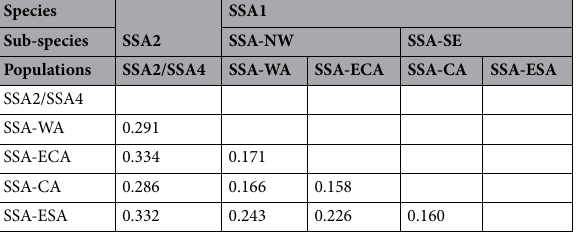
Table 1. Population substructure based on the F -statistics ( F st ) of Weir and Cockerham 45 .